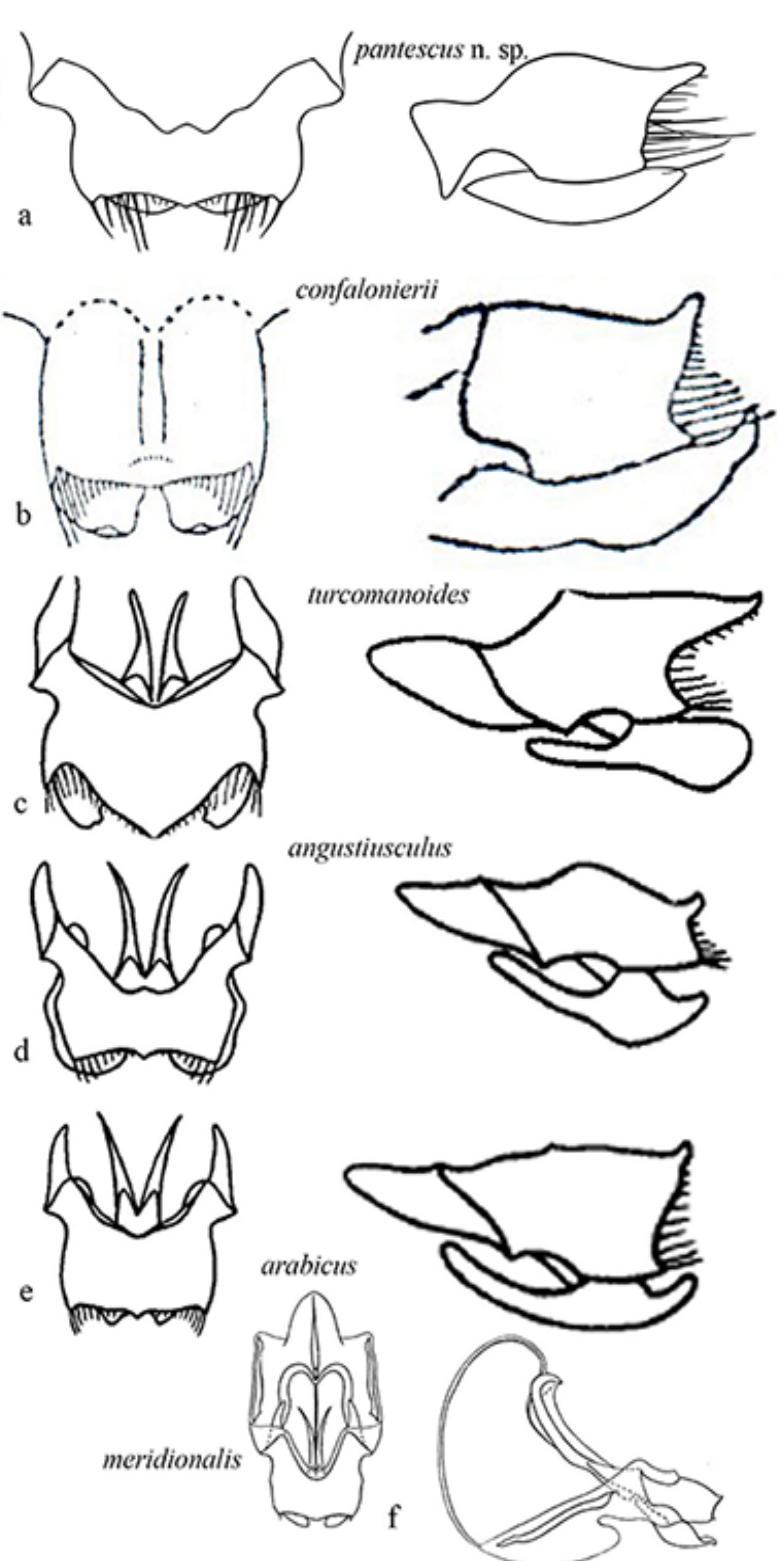
Figure 9. Genitalia of some Mediterranean species of Acheta . On the left epiphallus and ectoparameres from above, on the right is the left lateral view: ( a ) Acheta pantescus n. sp.; ( b ) A. confalonierii (after Capra) [17]; ( c ) A. turcomanoides (after Gorochov) [3]; ( d ) A. angustiusculus (after Gorochov) [3]; ( e ) A. arabicus (after Gorochov) [3]; ( f ) A. meridionalis (after Gorochov & Llorente) [22] (with permission by the